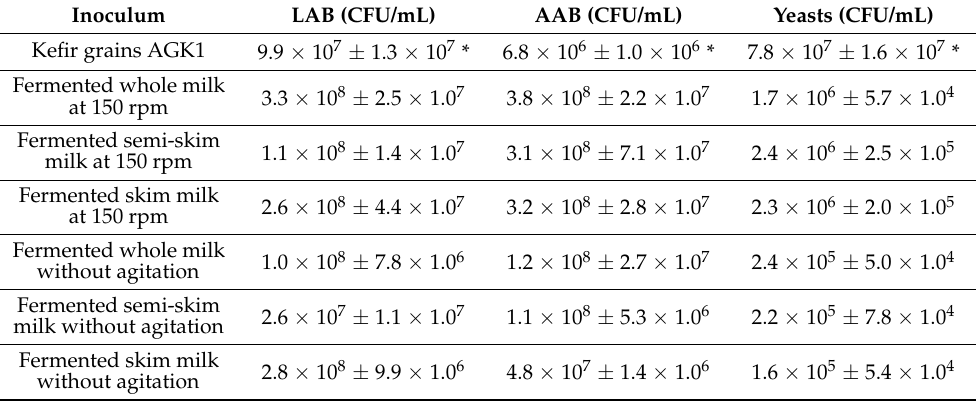
Table 1. Microbiological composition (in mean colony forming units (CFU) ± standard deviation/mL or g) of the different inocula used in this work. Inoculum LAB (CFU/mL) AAB (CFU/mL) Kefir grains